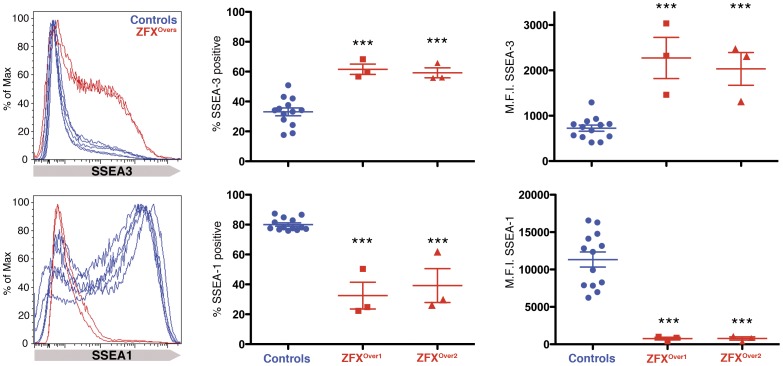
ZFXOver clones resist spontaneous differentiation.A. ZFXOver clones and controls were expanded in conditions promoting self-renewal before SSEA-3 and SSEA-1 FACS analysis. B. ZFXOver clones and controls were expanded in suboptimal conditions before SSEA-3 and SSEA-1 FACS analysis. The quantitation compares ZFXOver clones to controls in three independent experiments and error bars represent the S.E.M. See Figure S5 for all 3 independent experiments.